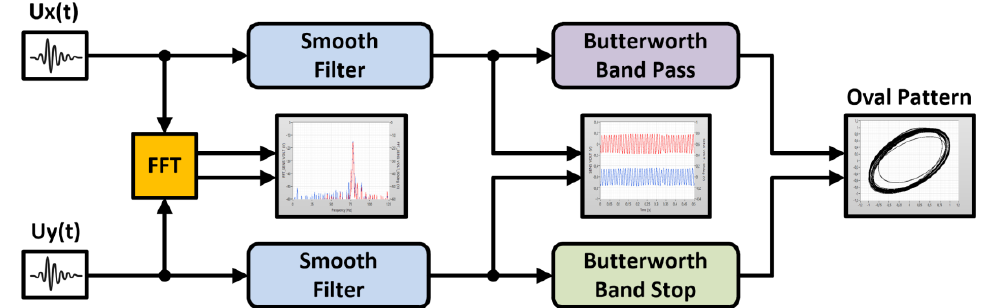
Figure 14. Signal processing diagram from active and passive sensors.